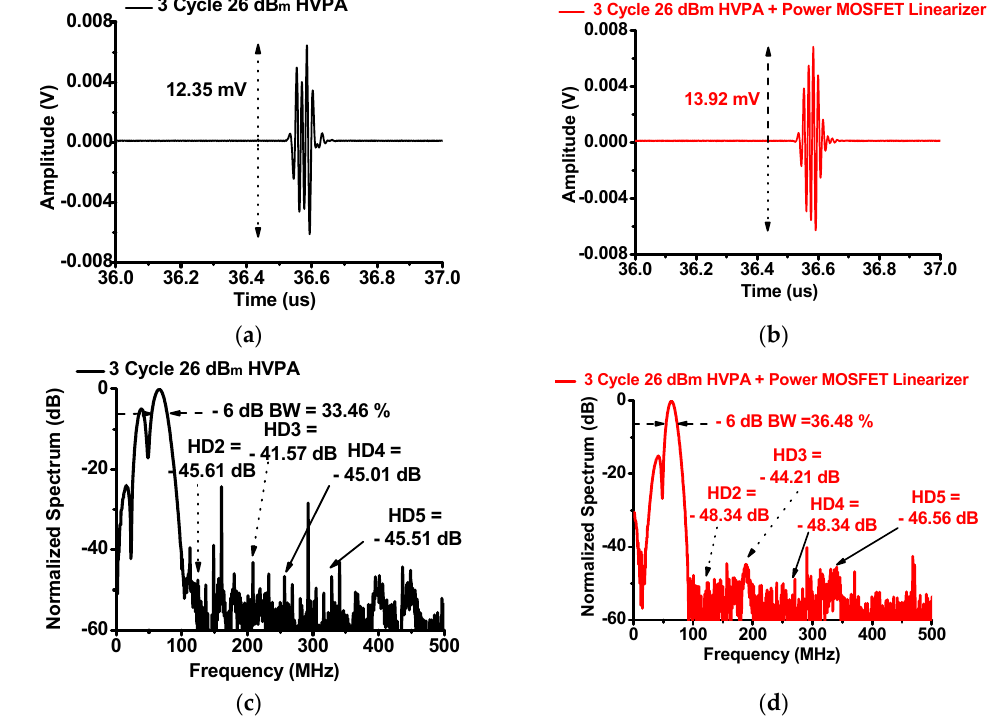
Figure 10. The echo amplitude of the HVPA ( a ) without and ( b ) with the power MOSFET linearizer and the spectrum of the HVPA ( c ) without and ( d ) with the power MOSFET linearizer when three-cycle 26 dB m input power was applied.